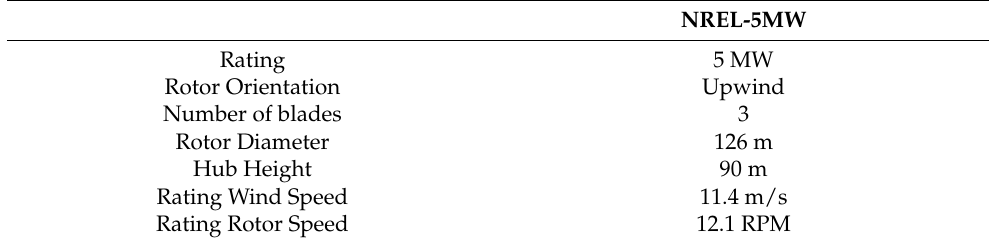
Table 1. NREL-5MW standard turbine parameters.